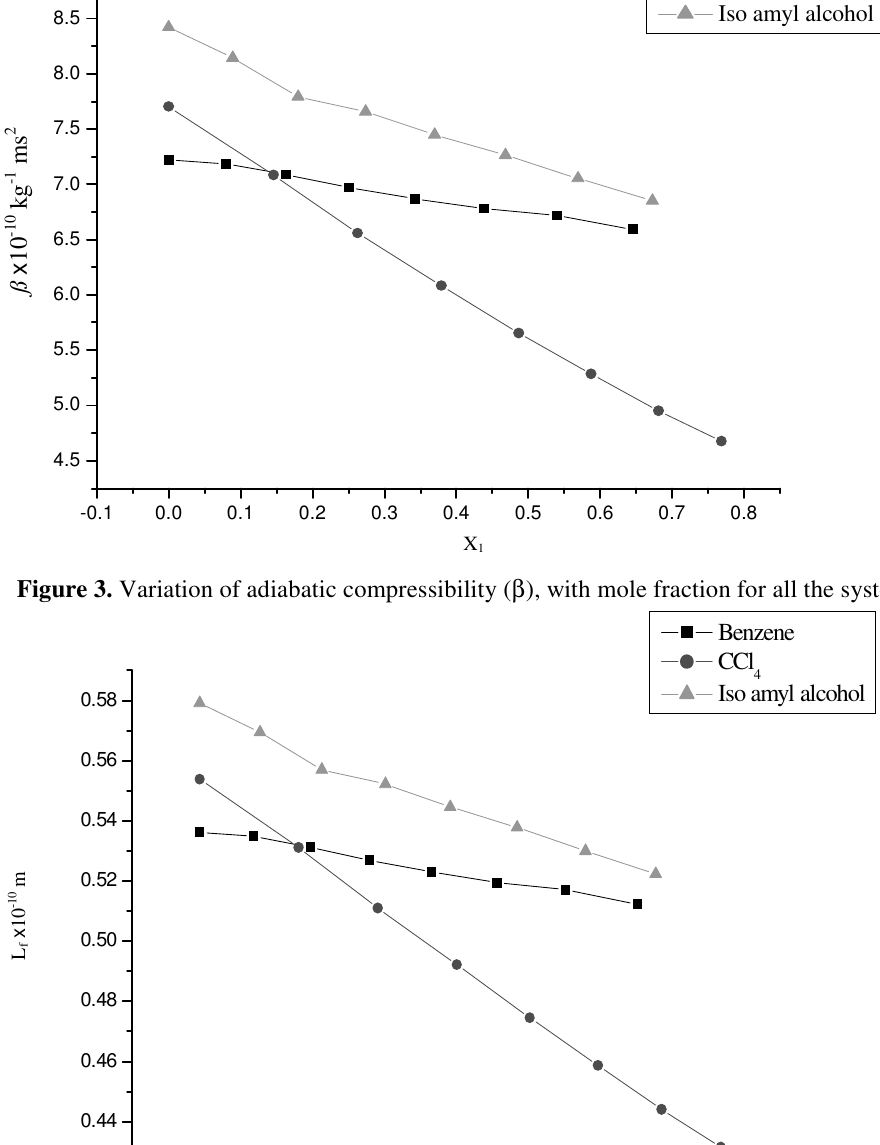
), with mole fraction for all the f